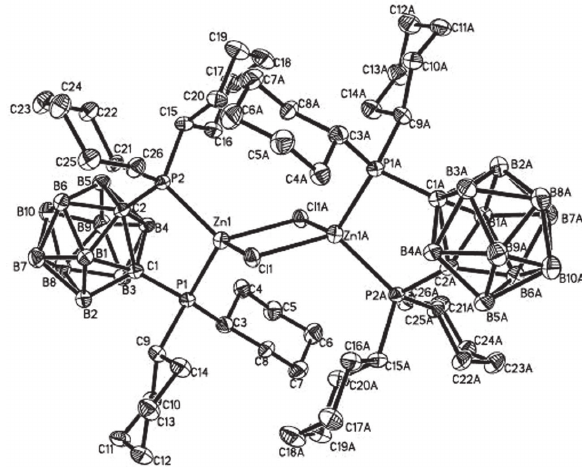
Table 1: Data collection and